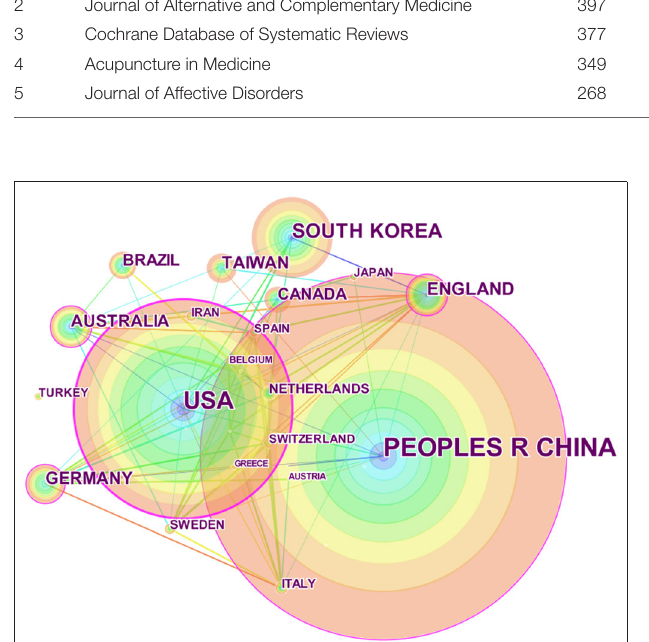
FIGURE 3 | Map of countries researching acupuncture for depression from 2011 to 2020.